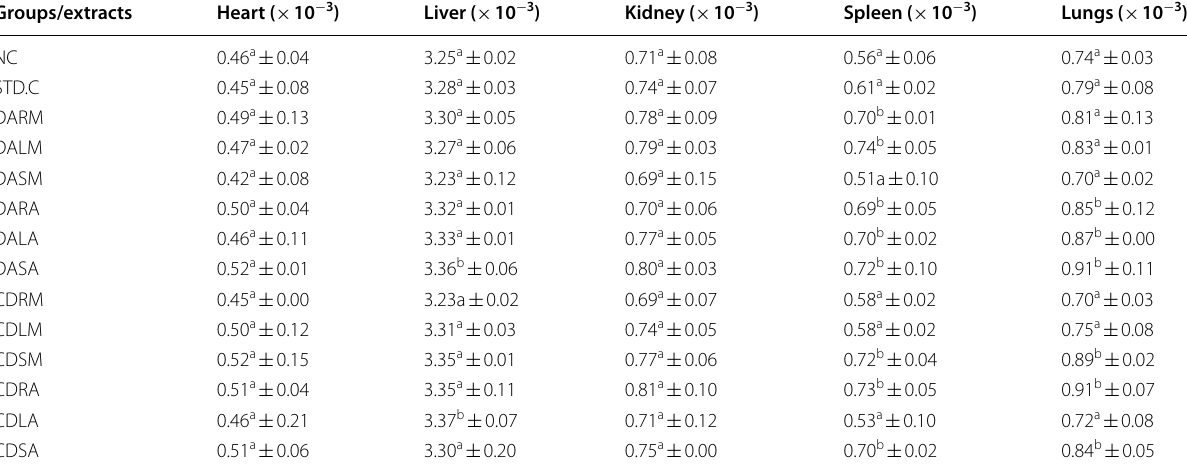
Values are mean SEM of 6 replicates ± a Statistically different ( p < 0.05) from the normal and standard controls b Statistical difference ( p < 0.05) from the normal and standard controls